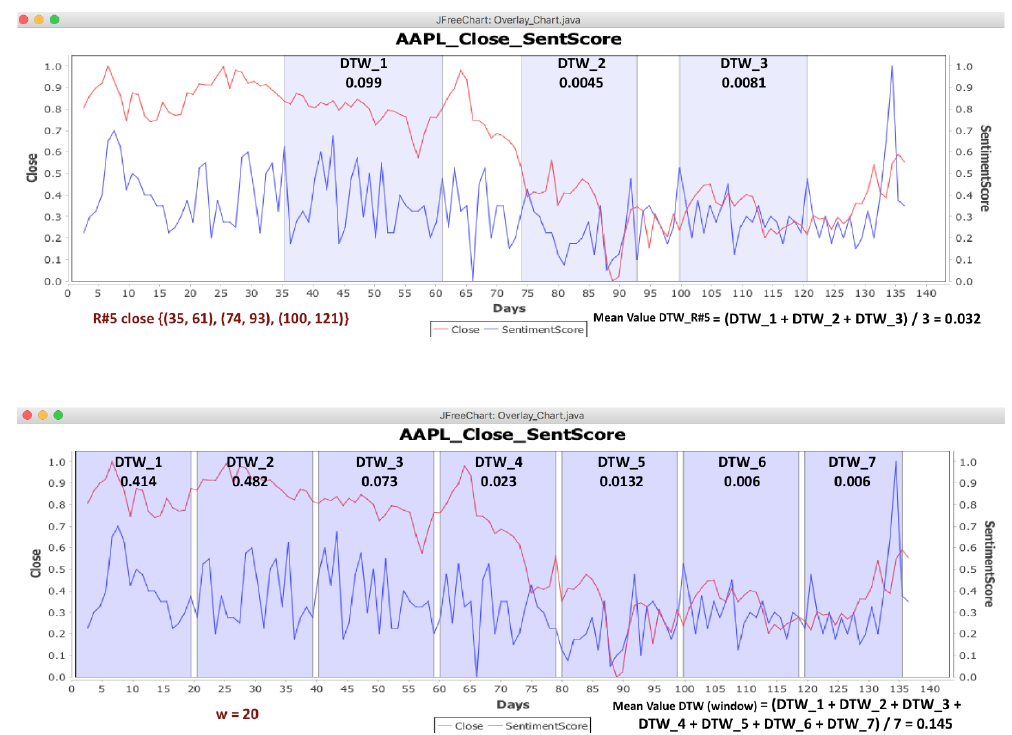
Figure 6. If mean value DTW (R) < mean value DTW (w), where R: rule, w: window (random window size), then there exists a correlation between the two time